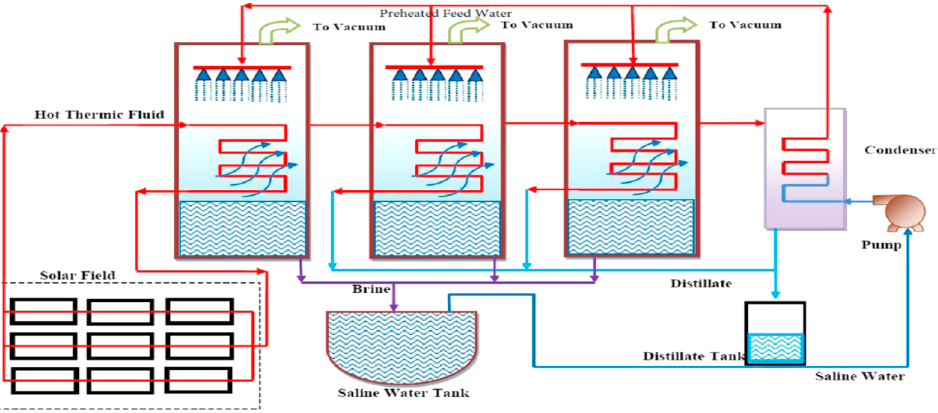
Figure 9. Solar powered Multi-Effect Distillation [72].